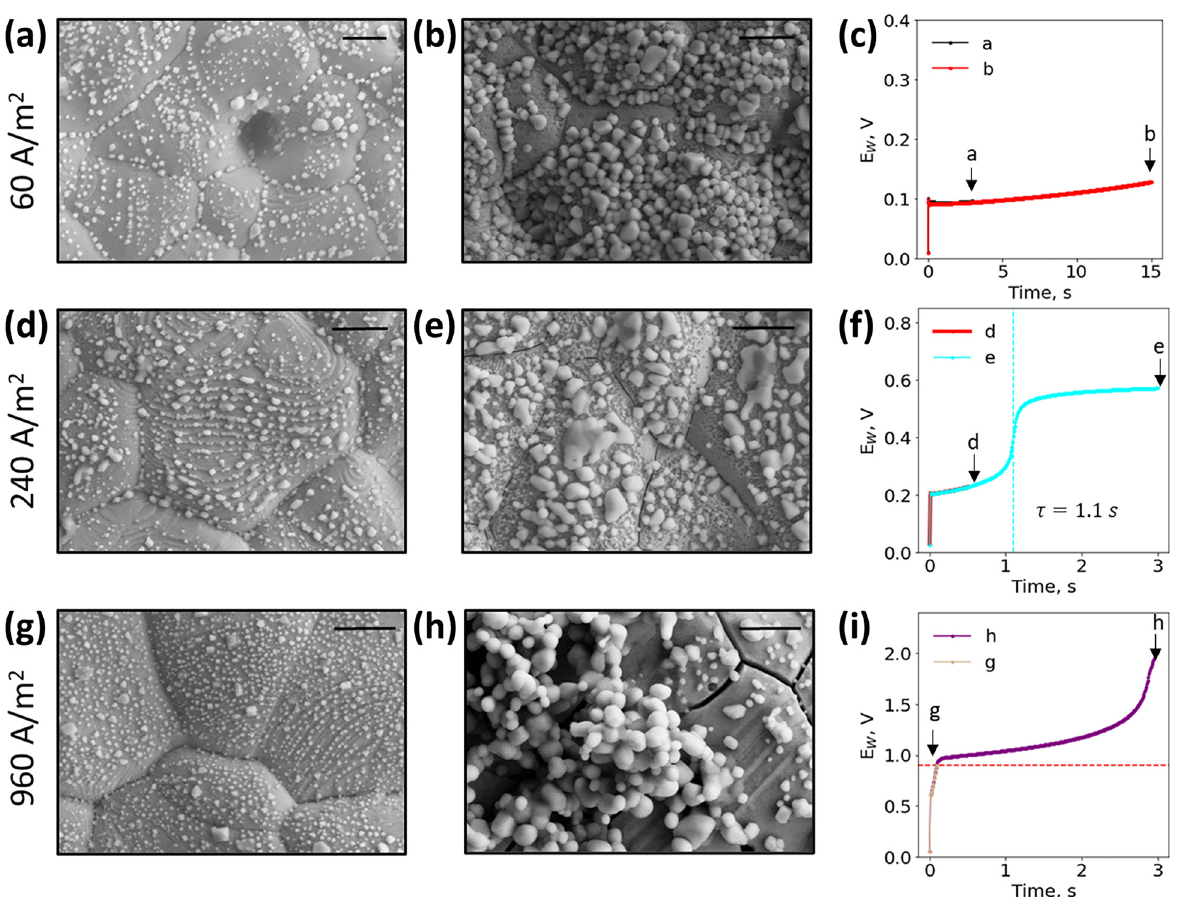
Figure 3. Scanning electron microscopy images of 50 mM NaCl and 20 mM Na 2 SO 4 at 25 °C at ( a ) 60 A/m 2 after running for 3 s and ( b ) after 15 s; at 240 A/m 2 for ( d ) 0.5 s prior to transition time and ( e ) 3 s after transition time; at 960 A/m 2 with a ( g ) voltage cutoff of 0.9 V and ( h ) without a voltage cutoff running for 3 s. Each experiment was used with a fresh screen ‐ printed electrode. The corresponding chronopotentiogram for the 60 A/m 2 , 240 A/m 2 , and 960 A/m 2 experiments are found in ( c , f , i ), respectively. The potential cutoff is represented by a horizontal red line. The transition time is represented by a vertical cyan line. All scale bars are 2.5 μ m.